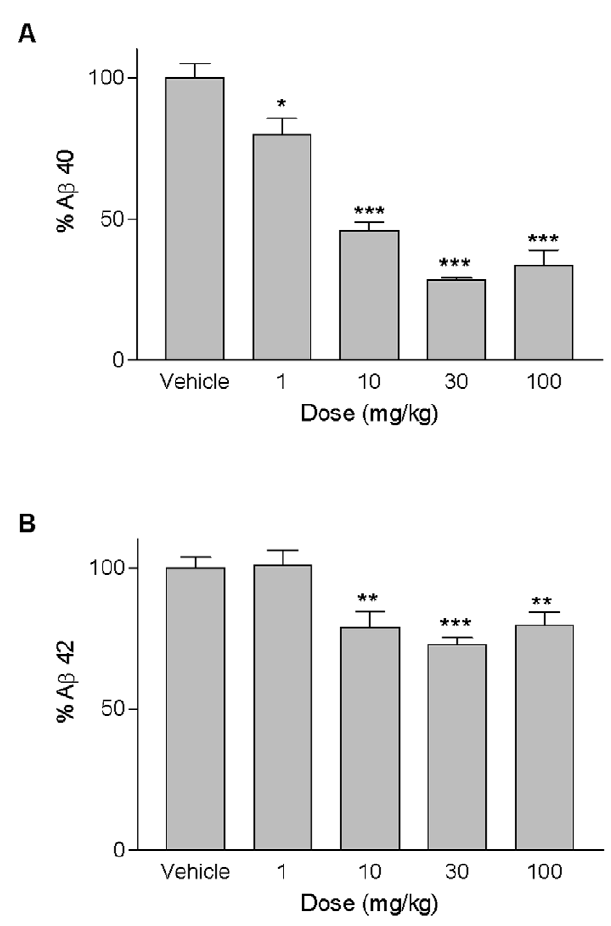
Figure 7. Effect of a c -secretase inhibitor on soluble brain A b 40 and A b 42. MRK-560/compound 32 was applied p.o. to hemizygous transgenic mice and brain A b levels were analysed 4 h post-dosing. Soluble A b 40 (A) and A b 42 (B) were significantly reduced after treatment with the c -secretase inhibitor. Data are expressed as means + SEM. (*) p=0.0176, (**) p , 0.005, (***) p , 0.0001 versus